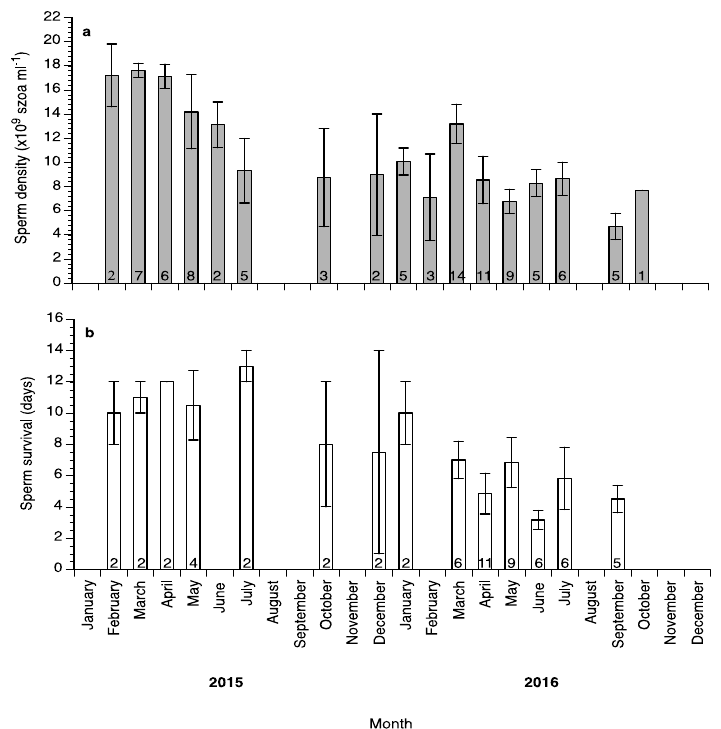
Figure 7. Mean (±SD) sperm density ( a ) and survival at 4 °C ( b ) of sperm collected from wreckfish between February 2015 and October 2016. Different numbers inside the bars indicate the number of sperm samples used.